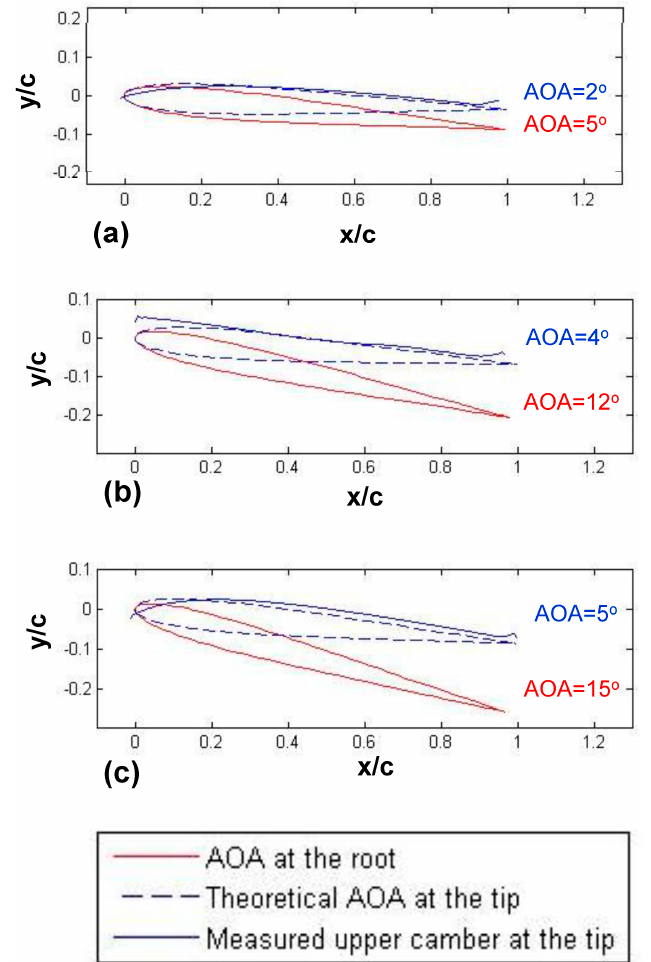
Figure 15. AOA at the root and at the tip of the wing, at Re = 30,000: ( a ) AOA root = 5°, AOA tip = 2°; ( b ) AOA root = 12°, AOA tip = 4°; (c) AOA root = 15°, AOA tip = 5°.